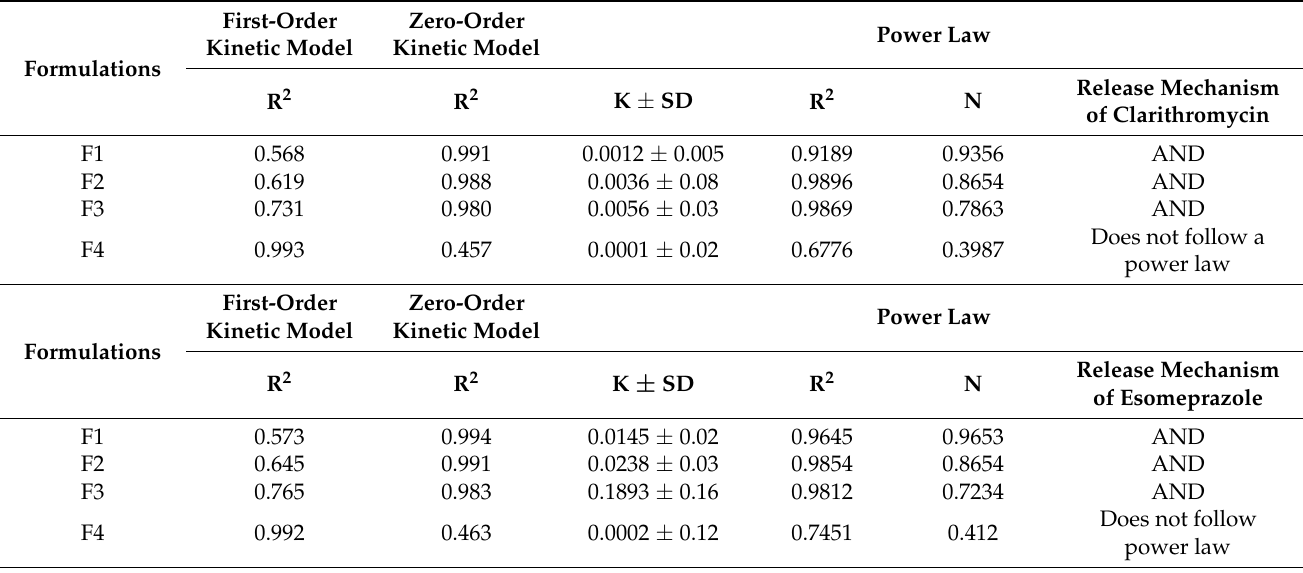
Table 6. The release mechanism of Clarithromycin and